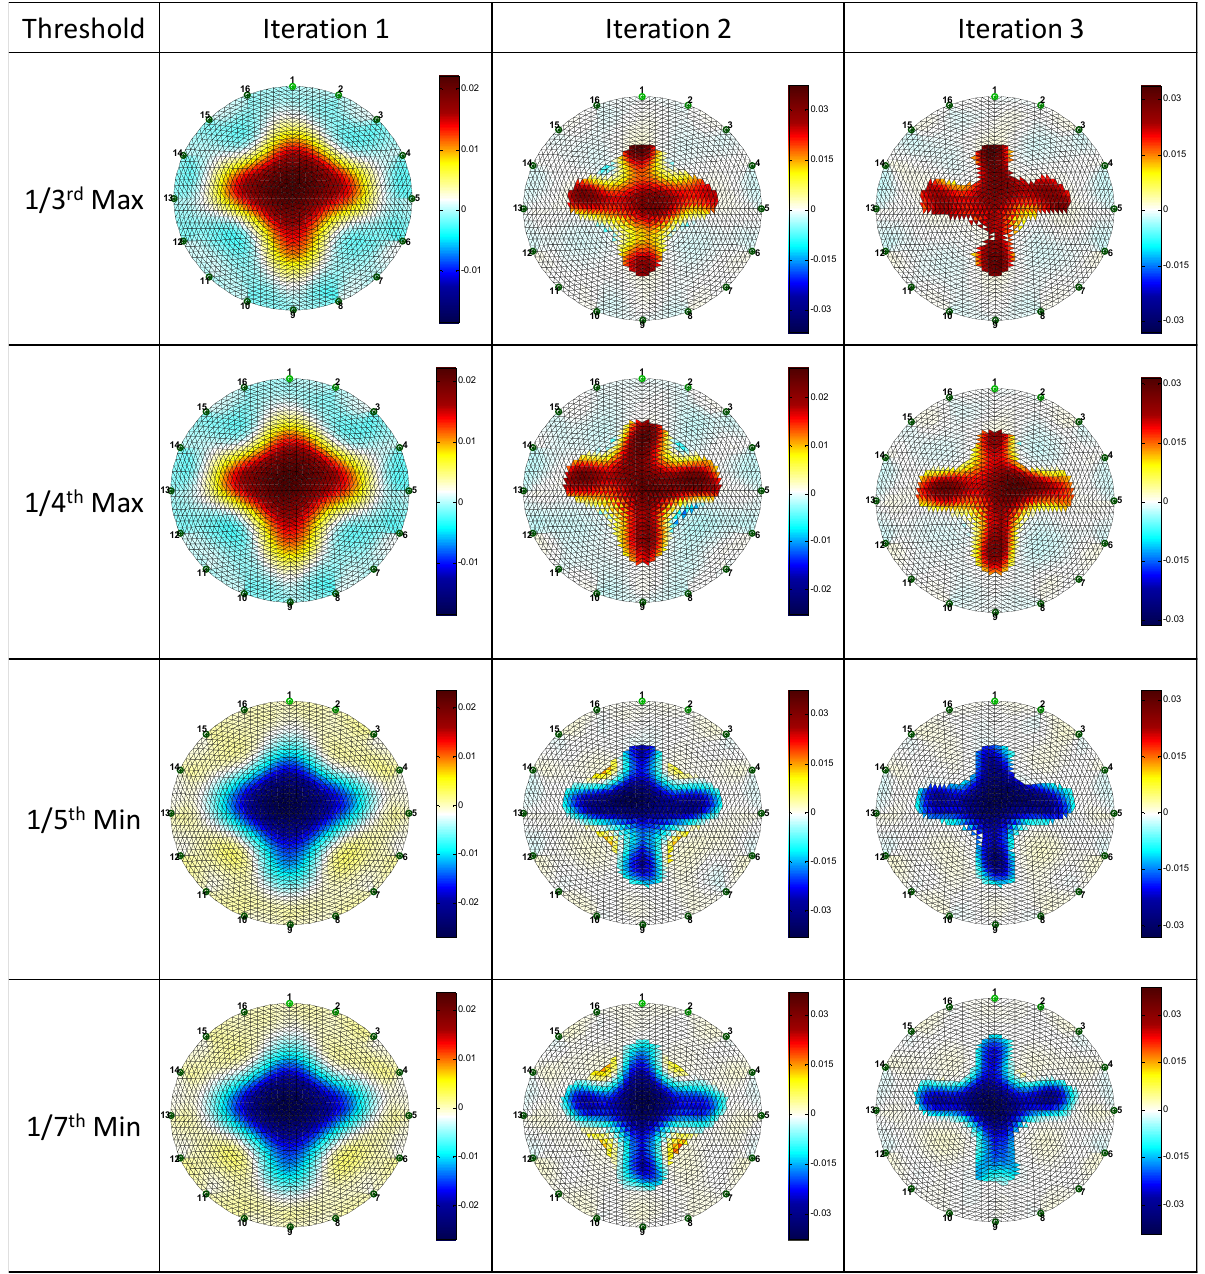
Fig.8: Effect of threshold on reconstruction of conducting and non-conducting objects.